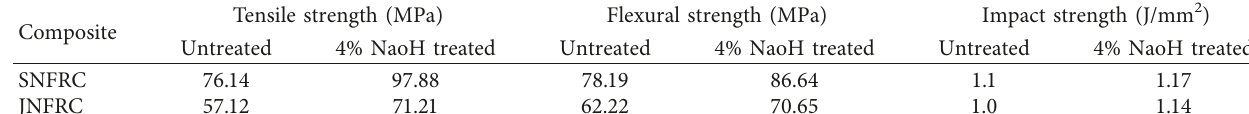
Table. 1: Properties of fabricated composites.